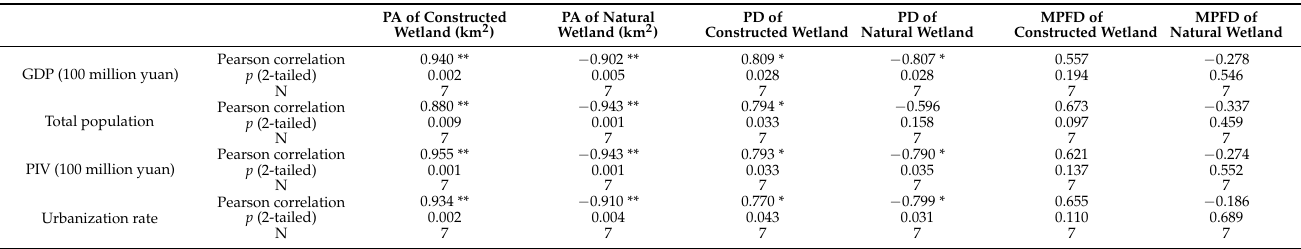
Figure 8. Trend lines of annual average temperature and annual precipitation from 1980 to 2015. Table 5. Correlation analysis of wetland landscape and economic